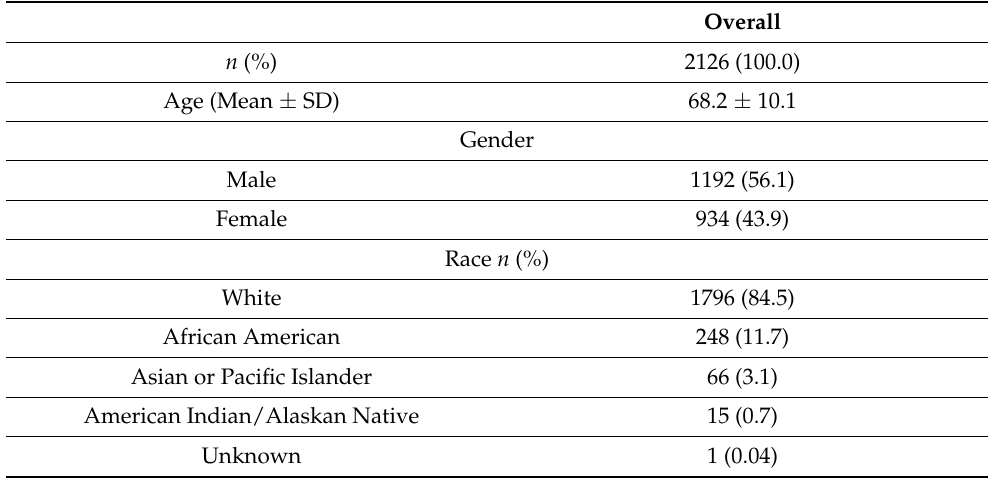
Table 1. Demographics and Clinical Profile of 2126 Patients with Combined Small-Cell Lung Cancer from Surveillance Epidemiology and End Result (SEER) Database